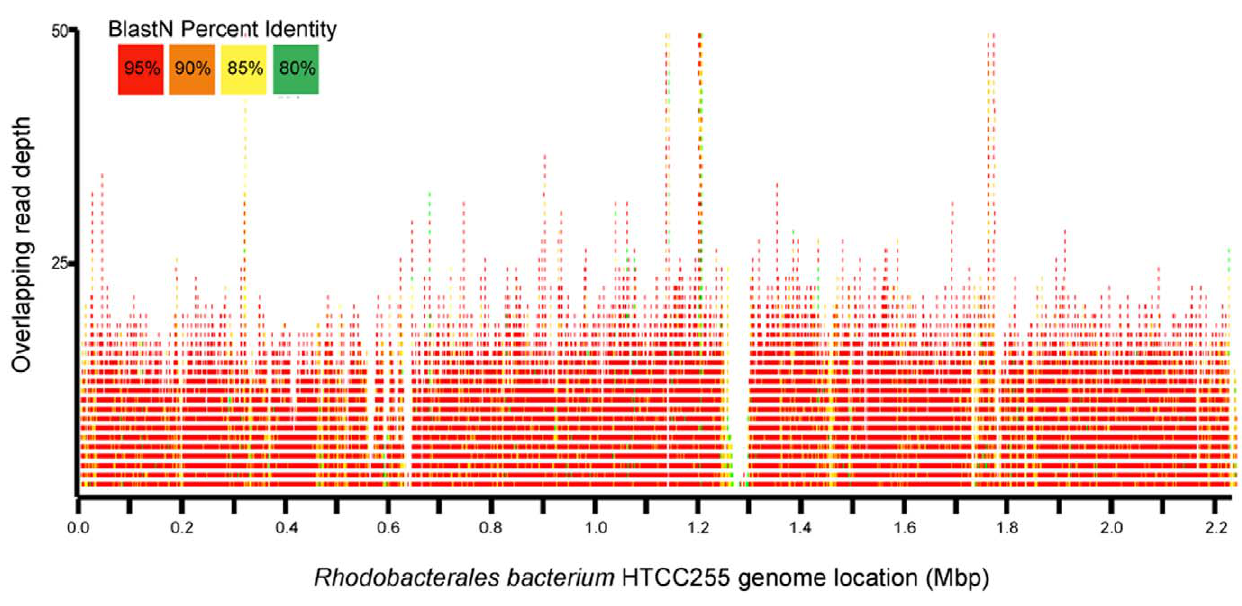
Figure 4. Recruitment plot of the unassembled Puget Sound reads to the alpha-Proteobacterium HTCC2255 genome assembly. Open Sound and Marina metagenomic sequence reads were recruited to the 2.23 MB assembly (GI number: 211594581) using BLASTN and an E- value cutoff of 10 2 5 . Over 91% of the assembly was matched at greater than 95% identity, equaling approximately 7X coverage.